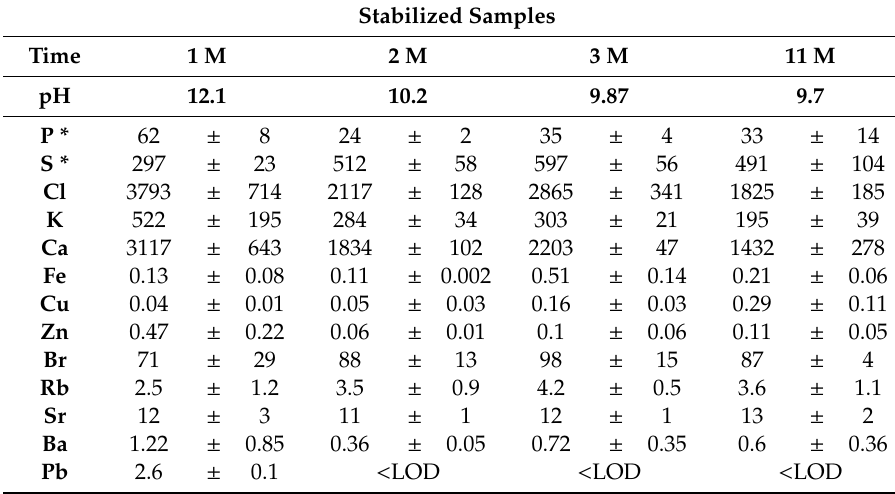
Table 2. Results of the TXRF analysis and pH values of leachate stabilized sample after 1, 2, 3 and 11 months. Values are expressed as the average ± standard deviation of three TXRF measurements. Relative sensitivities for elements with * were calculated based on a calibration curve (see the experimental section). LOD—lower detection